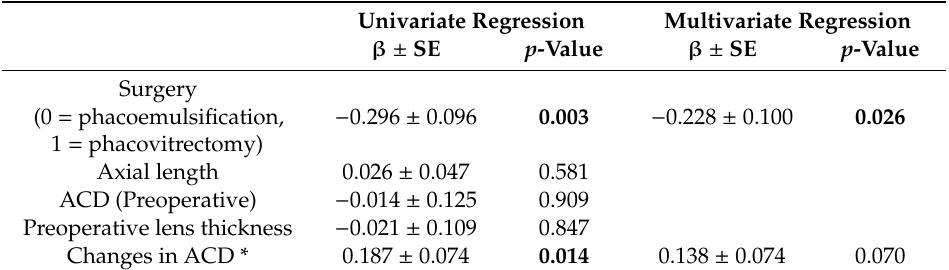
Table 4. Univariate and multivariate linear regression analyses between various clinical factors and postoperative prediction